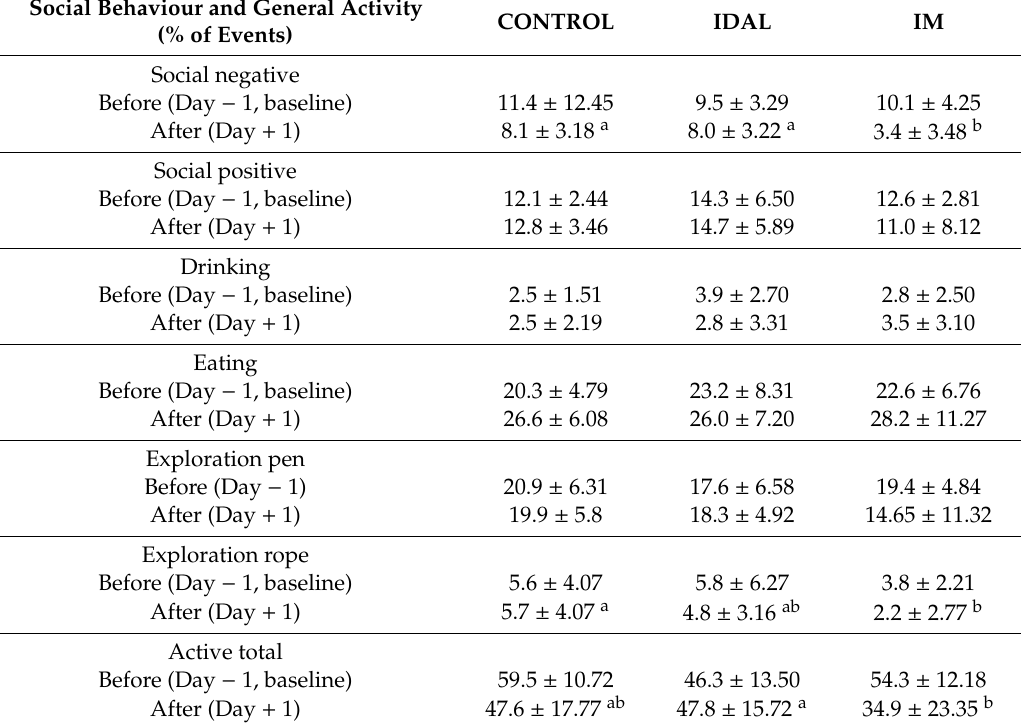
Table 3. Mean percentages of occurrence and Standard Deviation (SD) of behaviours recorded in the CONTROL, IDAL, and IM